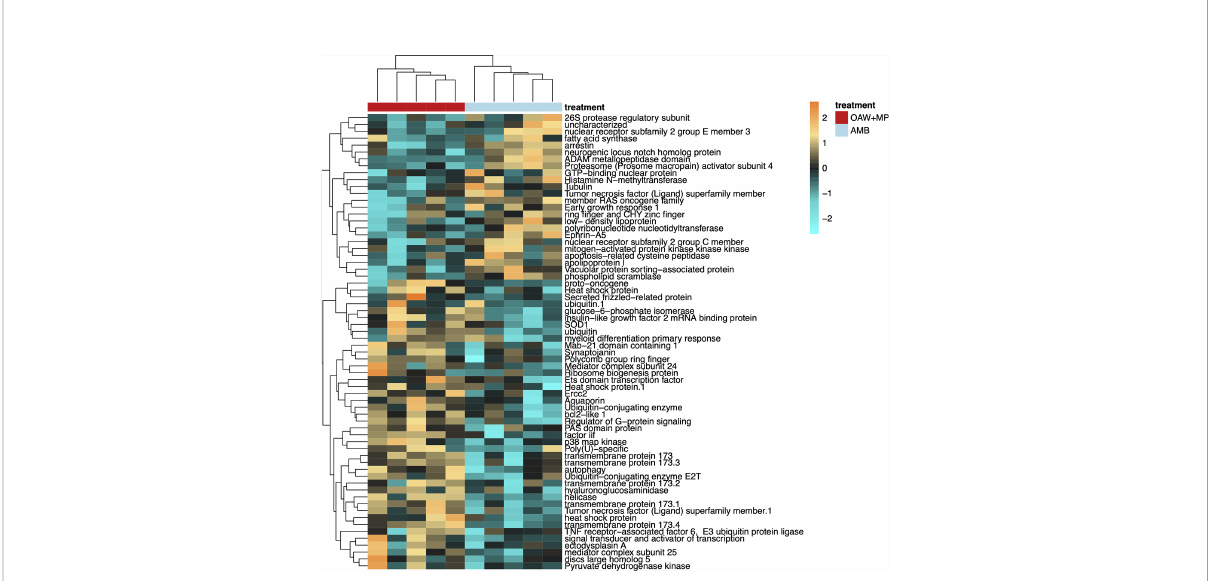
FIGURE 4 Differentially expressed genes (DEGs, unadjusted p -value < 0.10) with annotations associated with immunity gene ontology (GO) terms from Supplemental Figure 4 (green box). Heatmap showing annotated immunity genes where each row is a gene and each column is a unique gene expression sample. The color scale is in log2 (fold change relative to the gene ’ s mean) and genes and samples are clustered hierarchically based on Pearson ’ s correlation of their expression across samples. Colored blocks indicate treatment. Hierarchical clustering of libraries (columns) demonstrates strong differences in gene expression of immunity genes by treatment